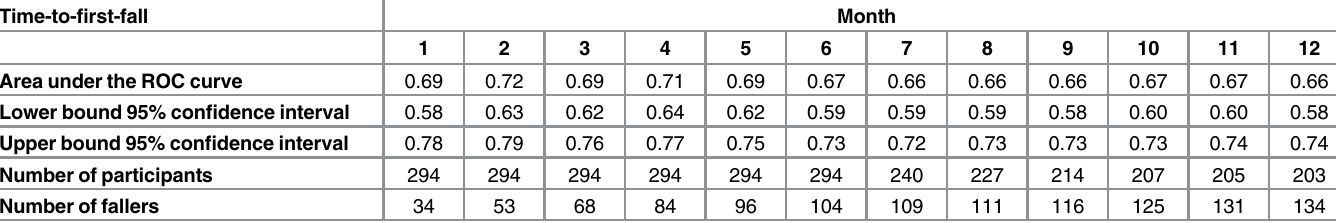
Table 3. Predictive ability of multivariate prediction model for time-to-first-fall.